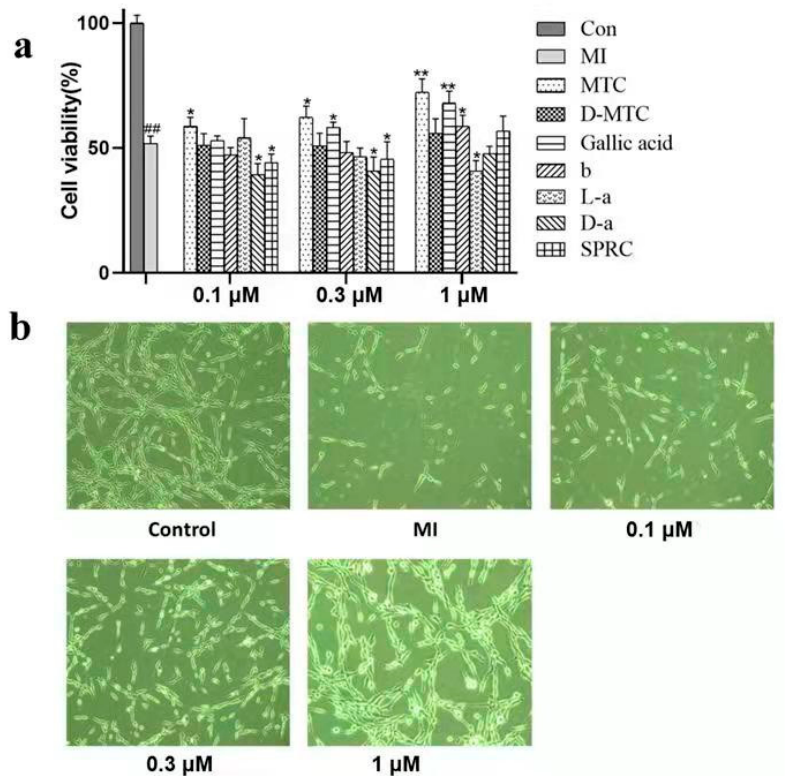
Figure 1. ( a ) The effects of 7 compounds treated with different concentrations (0.1 µ M, 0.3 µ M, 1 µ M) for 24 h on cell viability after ischemia-reperfusion-induced PC12 cell injury. Which b is 3,4,5-trimethoxybenzoic acid, L-a is methyl S -(4-fluorobenzyl)- L -cysteinate, D-a is methyl S -(4-fluorobenzyl)- D -cysteinate. ( b ) Effects of MTC on PC12 injury induced by ischemia reperfusion. Data presented are mean ± SD and the figures shown are representative of three independent experiments. Compared with control group, ## p < 0.01; Compared with myocardial infarction group (MI) group, ** p < 0.01, * p < 0.05.